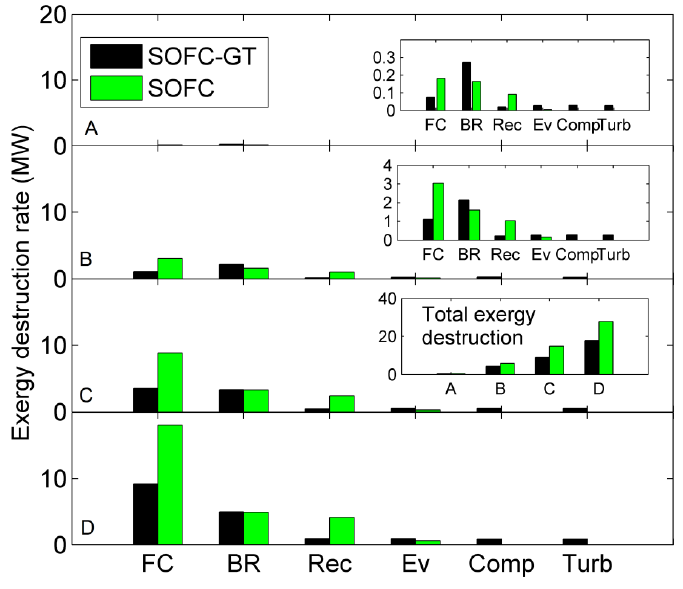
= 600 °C and U = FC f